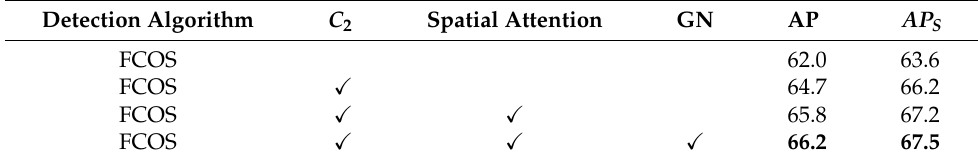
Table 4. Ablation experiments for AFE on HRSID.